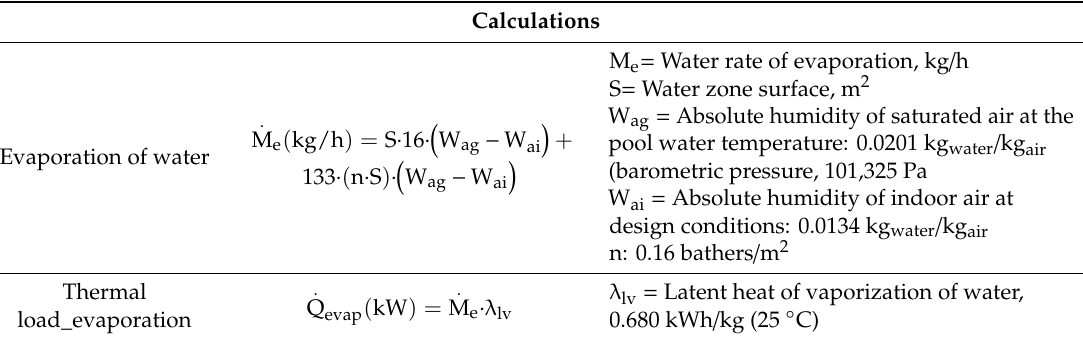
Table A8. Thermal load by evaporation (